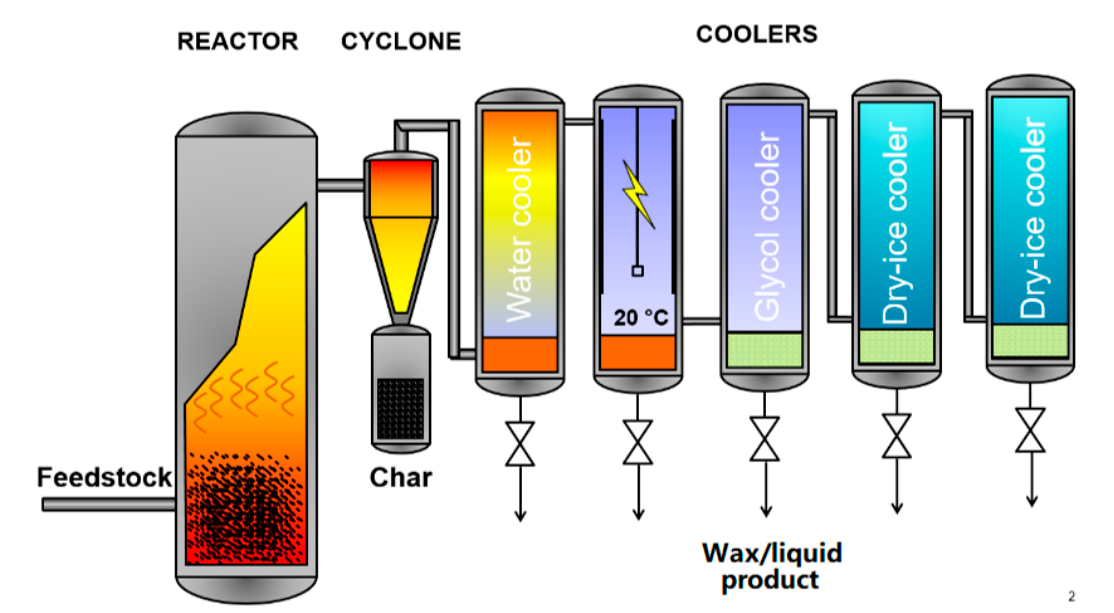
Figure 5. Bench scale unit used in the pyrolysis